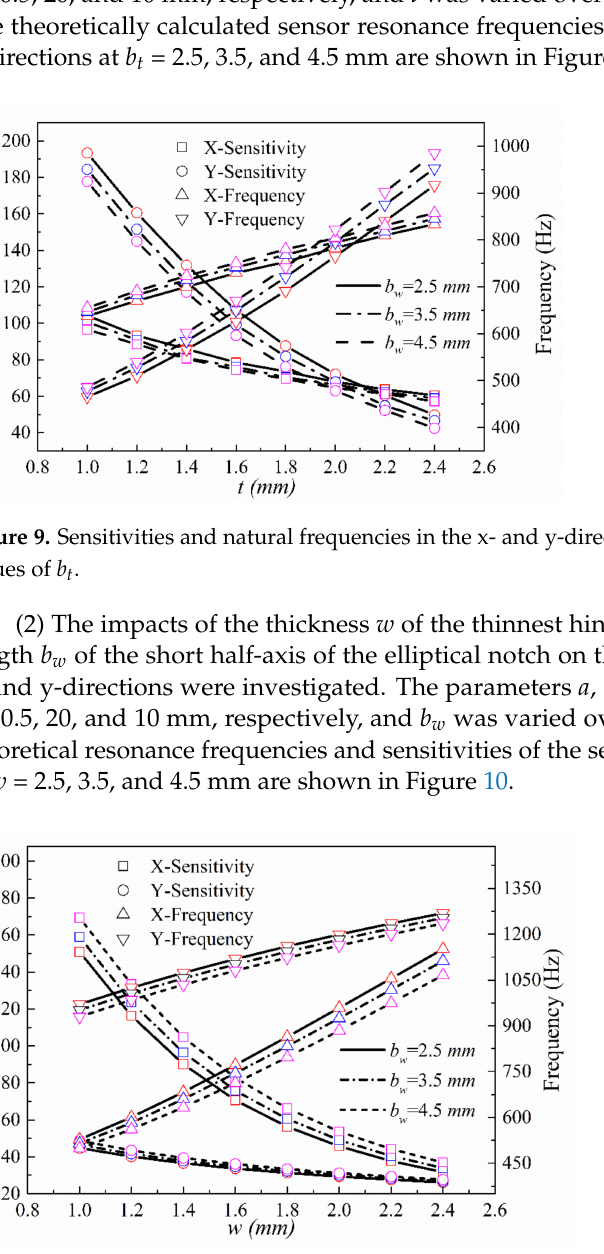
Figure 10. Sensitivities and natural frequencies in the x- and y-directions as a function of w at different values of b w